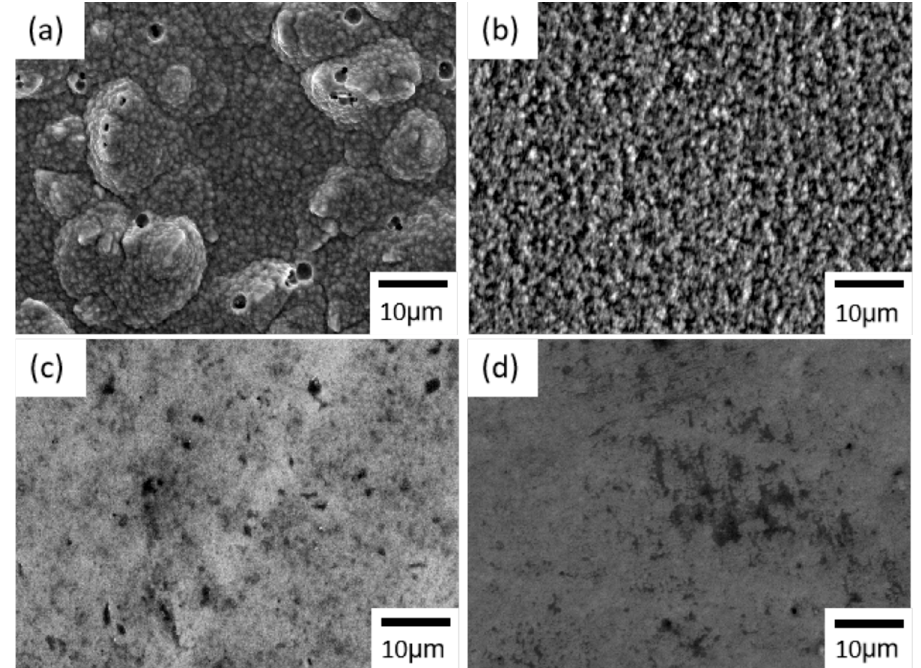
Figure 1. SEM images of the nickel–cobalt alloys electrodeposited with a current density at 15 mA/cm 2 and with the bath containing ( a ) no additives, ( b ) nickel bromide, ( c ) Surf-Bright and ( d ) both nickel bromide and the Surf-Bright.